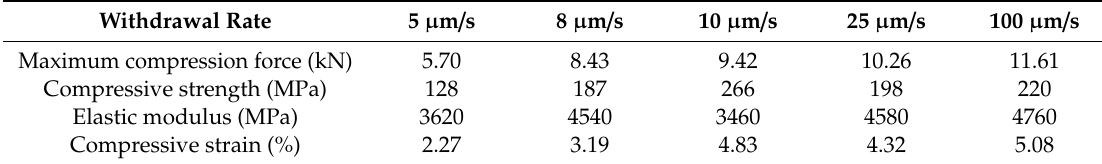
Figure 6. ( a ) The compressive strain–stress curves of directionally solidified CuCe alloy; ( b ) The relationship between the withdrawal rate and the maximum stress; ( c ) The microhardness of di ff erent phases. Table 4. The compression properties of CuCe alloy at di ff erent withdrawal